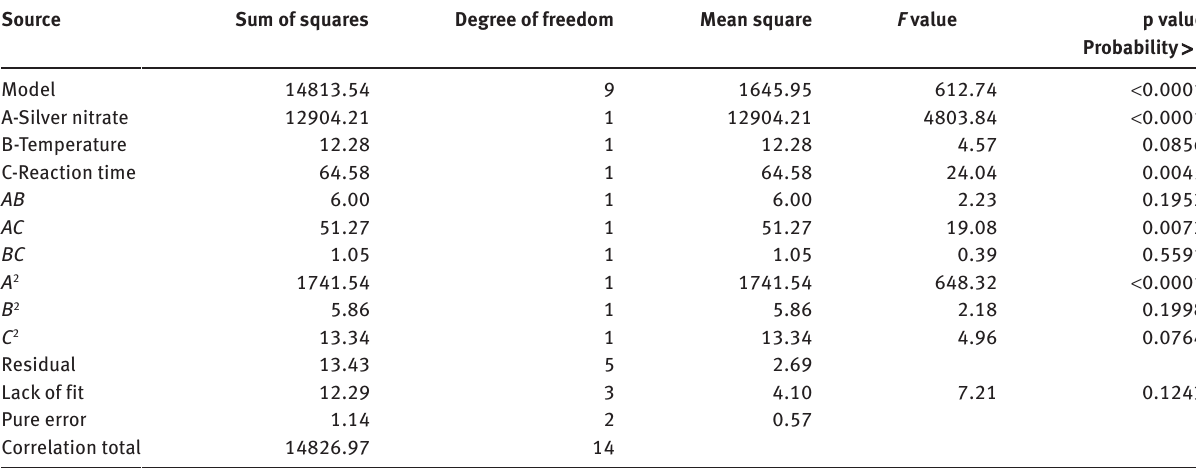
Table 4: ANOVA of the fitted second-order polynomial model for AgNPs